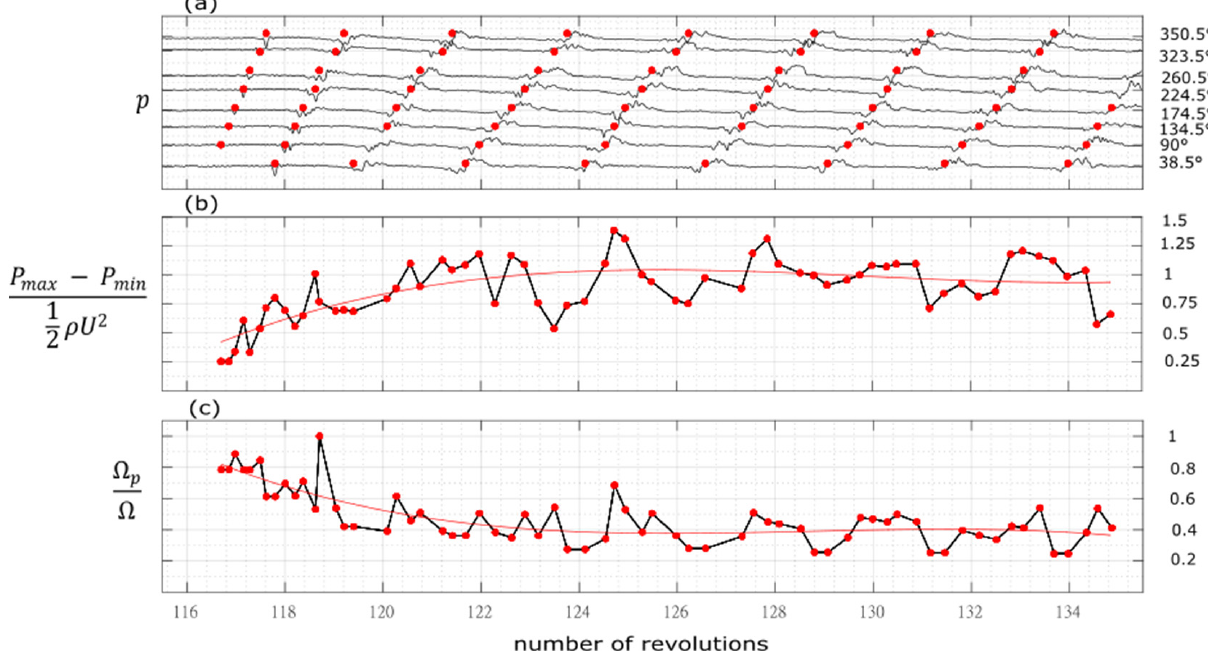
Figure 8. Stall transient with no grid; on the x axis the number of revolutions, on the y axis: ( a ) angular position of the signal, ( b ) non-dimensional pressure amplitude, ( c ) non-dimensional perturbation speed.